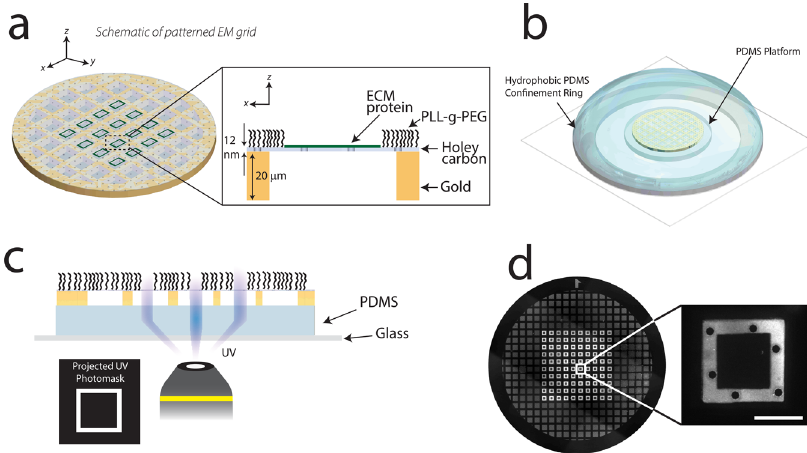
Fig. 1 | Micropatterning of holey carbon EM grids using photomolecular adsorption. a Schematic of patterned holey carbon fi lm of gold mesh grid, with customECMpatternssurroundedbyabio-passivationlayer. b Gridsareplacedona thin PDMS platform to eliminate physical contact with the carbon fi lm, which is